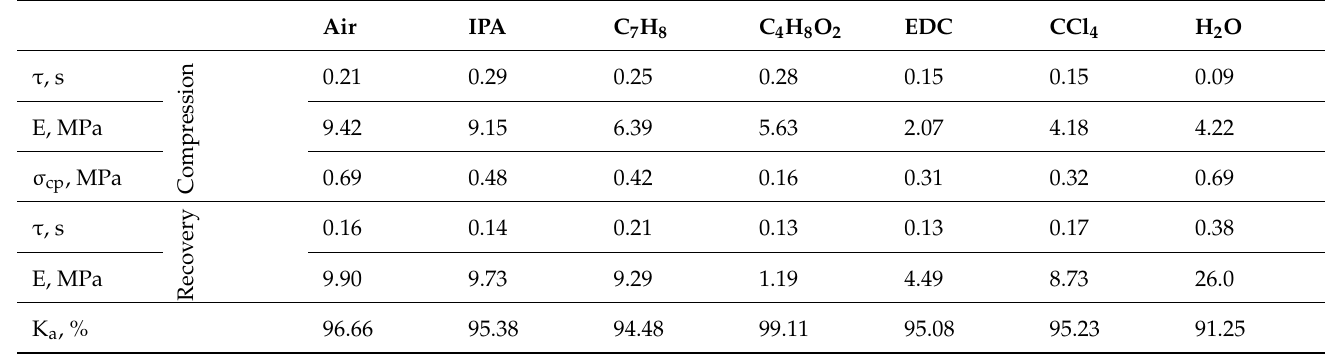
Table 4. Physical properties of the ‘composite–liquid’ system for the Explorer (NBR) blanket.